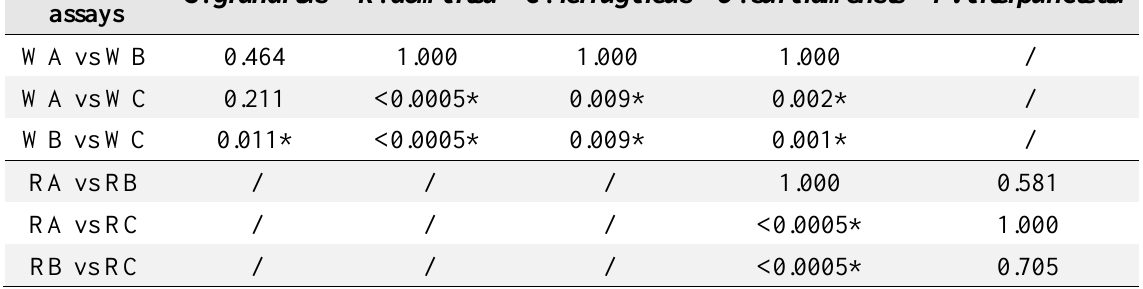
Table 2. Statistical differences (p) in the number of emerged adult insect pests that developed on different mechanical states (A, B, C) of wheat (W) and rye (R) kernels. Compared S . granarius assays WA vs WB 0.464 WA vs WC 0.211 WB vs